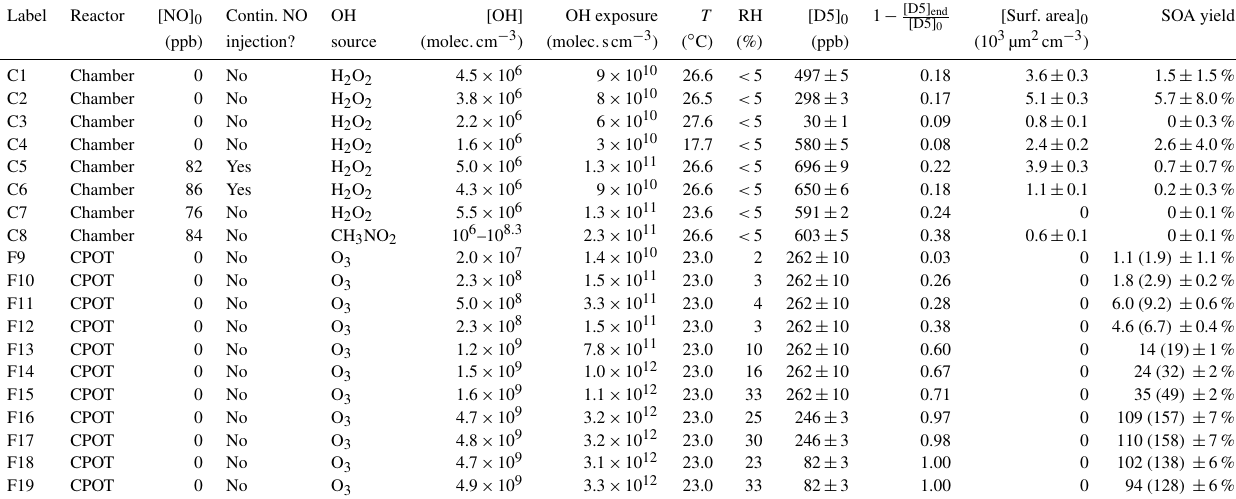
Table 1. Experimental conditions. For the CPOT experiments, the upper estimate of the wall-deposition-corrected SOA yield is shown in